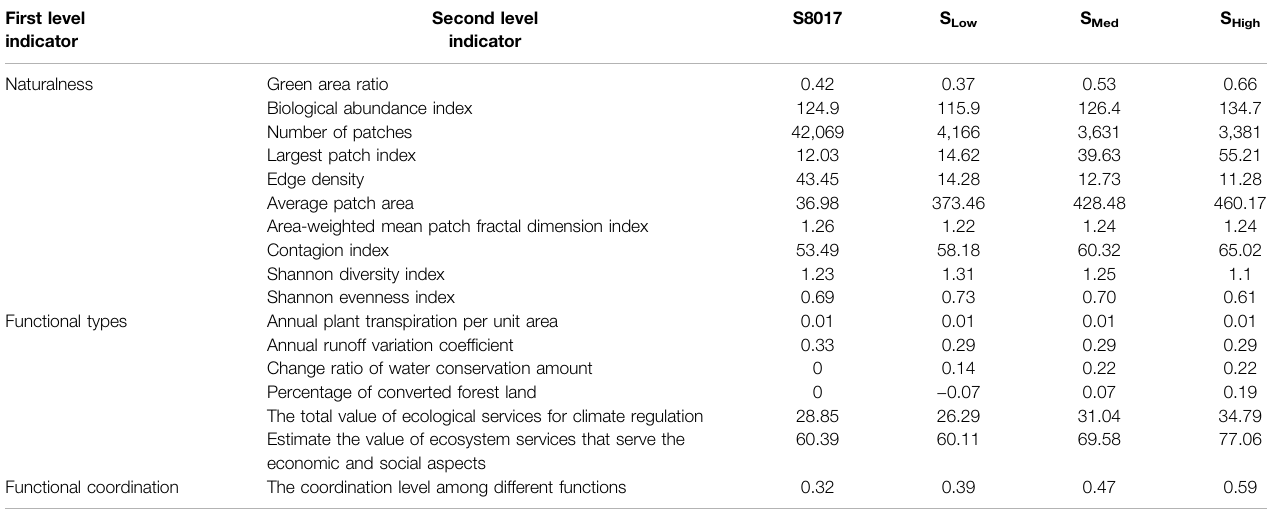
TABLE 7 | Evaluation results of individual indicators for different layout allocation schemes of slope ecological restoration.